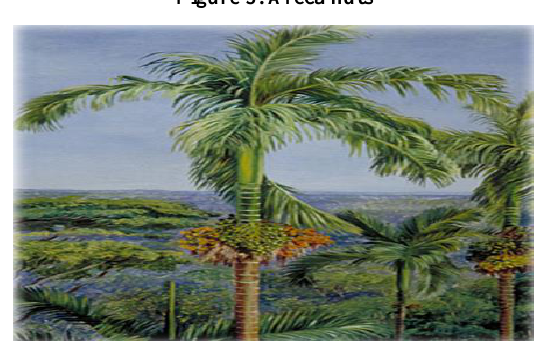
Figure 3. Areca nuts